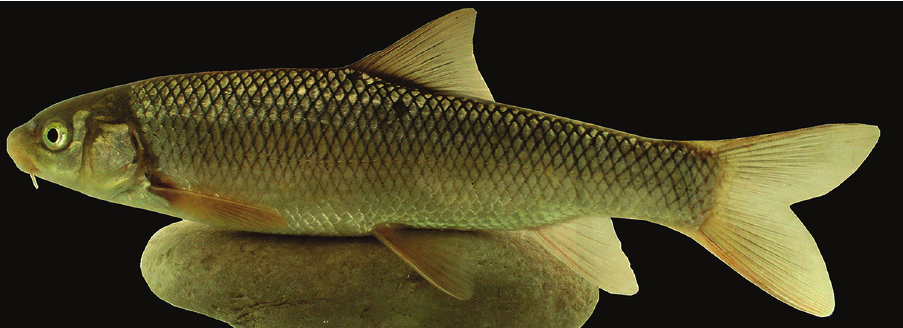
Figure 4. Capoeta razii sp. n., IMNRF-UT-1072-9, holotype, SL: 142.6 mm, Iran: Mazandaran Prov., Chalos city, Kheyroud River, Caspian Sea basin.